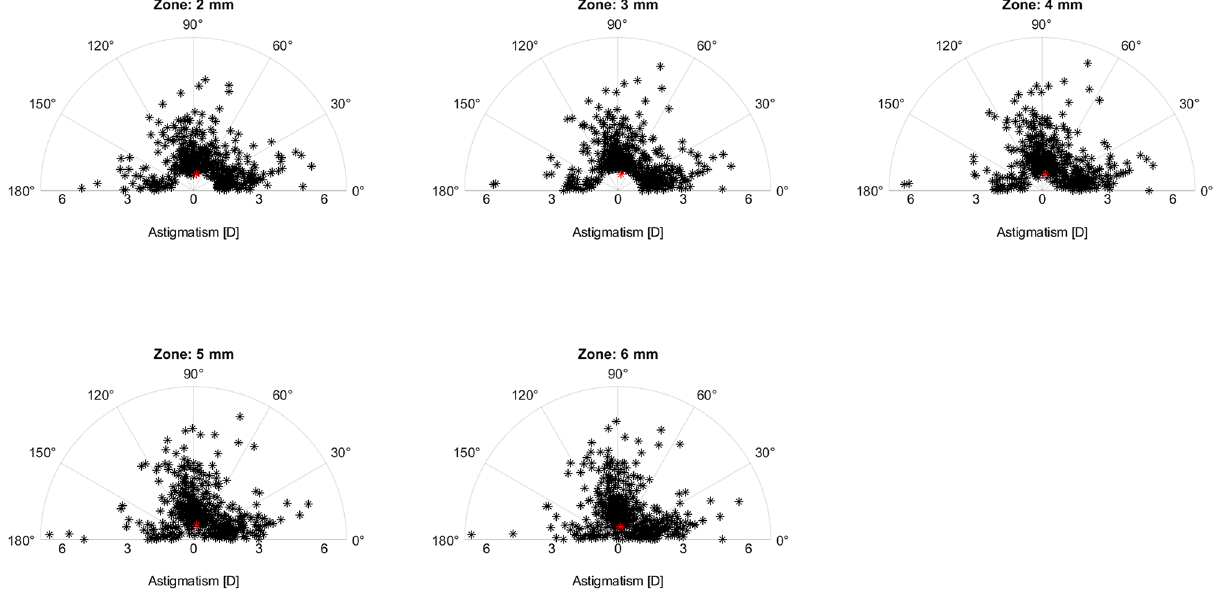
Figure 2. Single-angle polar plot of individual cornea astigmatism (black asterisk) of the study population. Red asterisks indicate the centroid for each corneal zone measured from 2 to 6 mm.